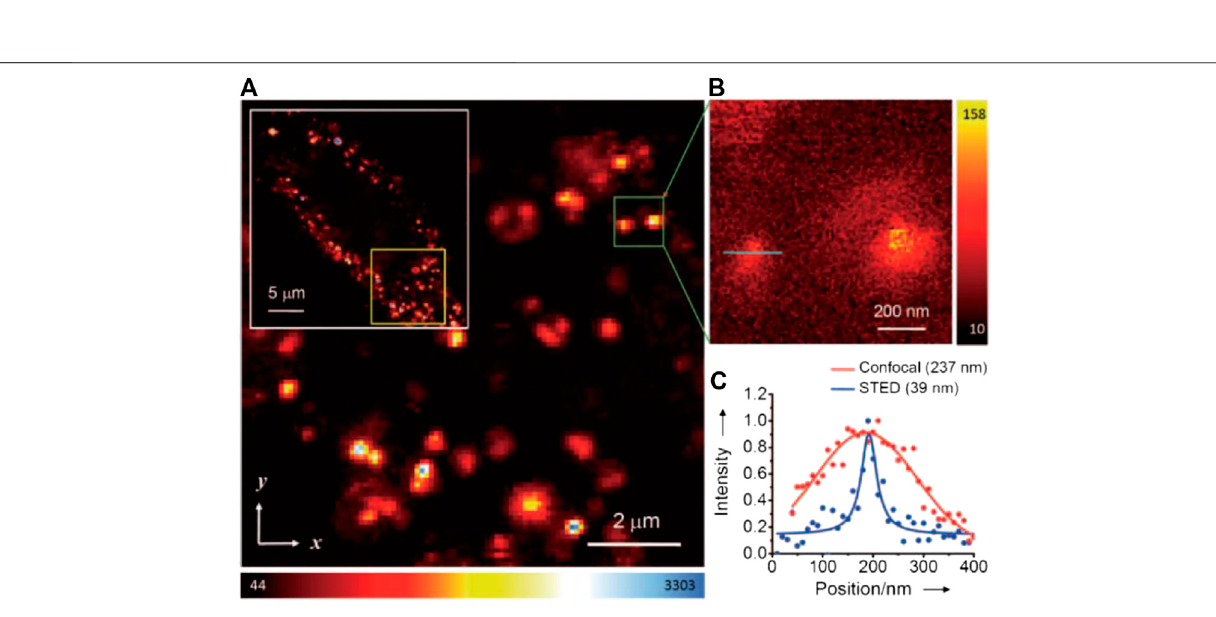
Frontiers in Chemistry |